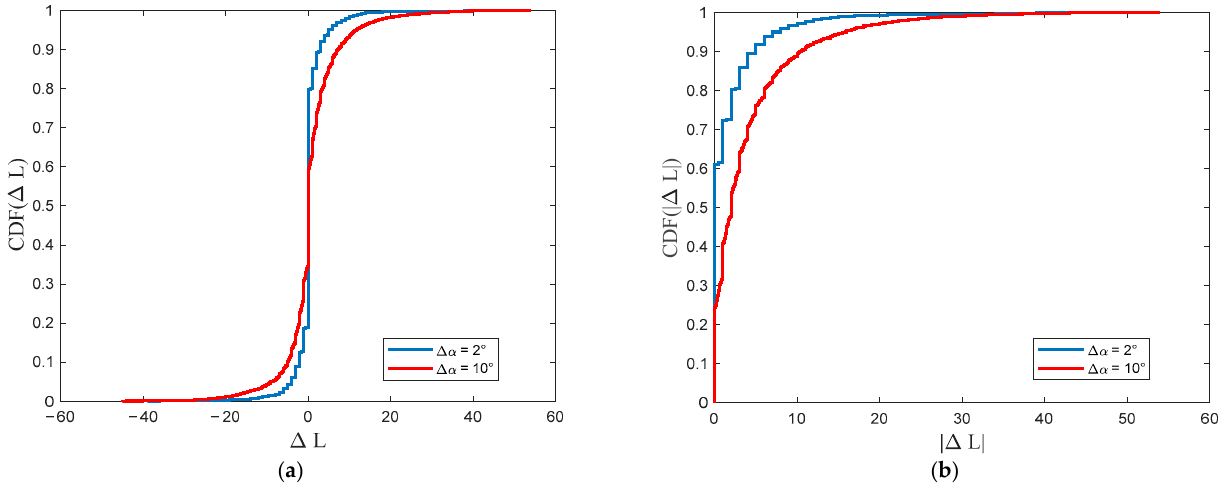
( ) Δ , RMSE L of the at-